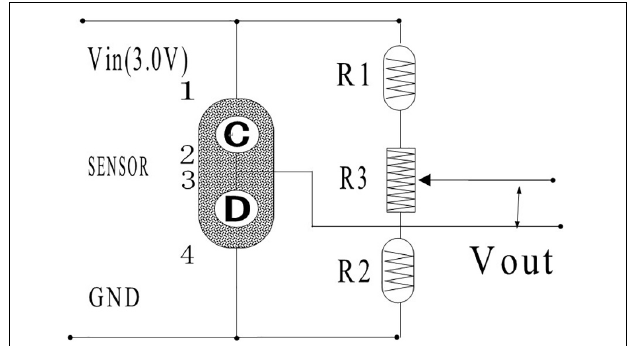
FIGURE 4 | Detection circuit of Wheatstone